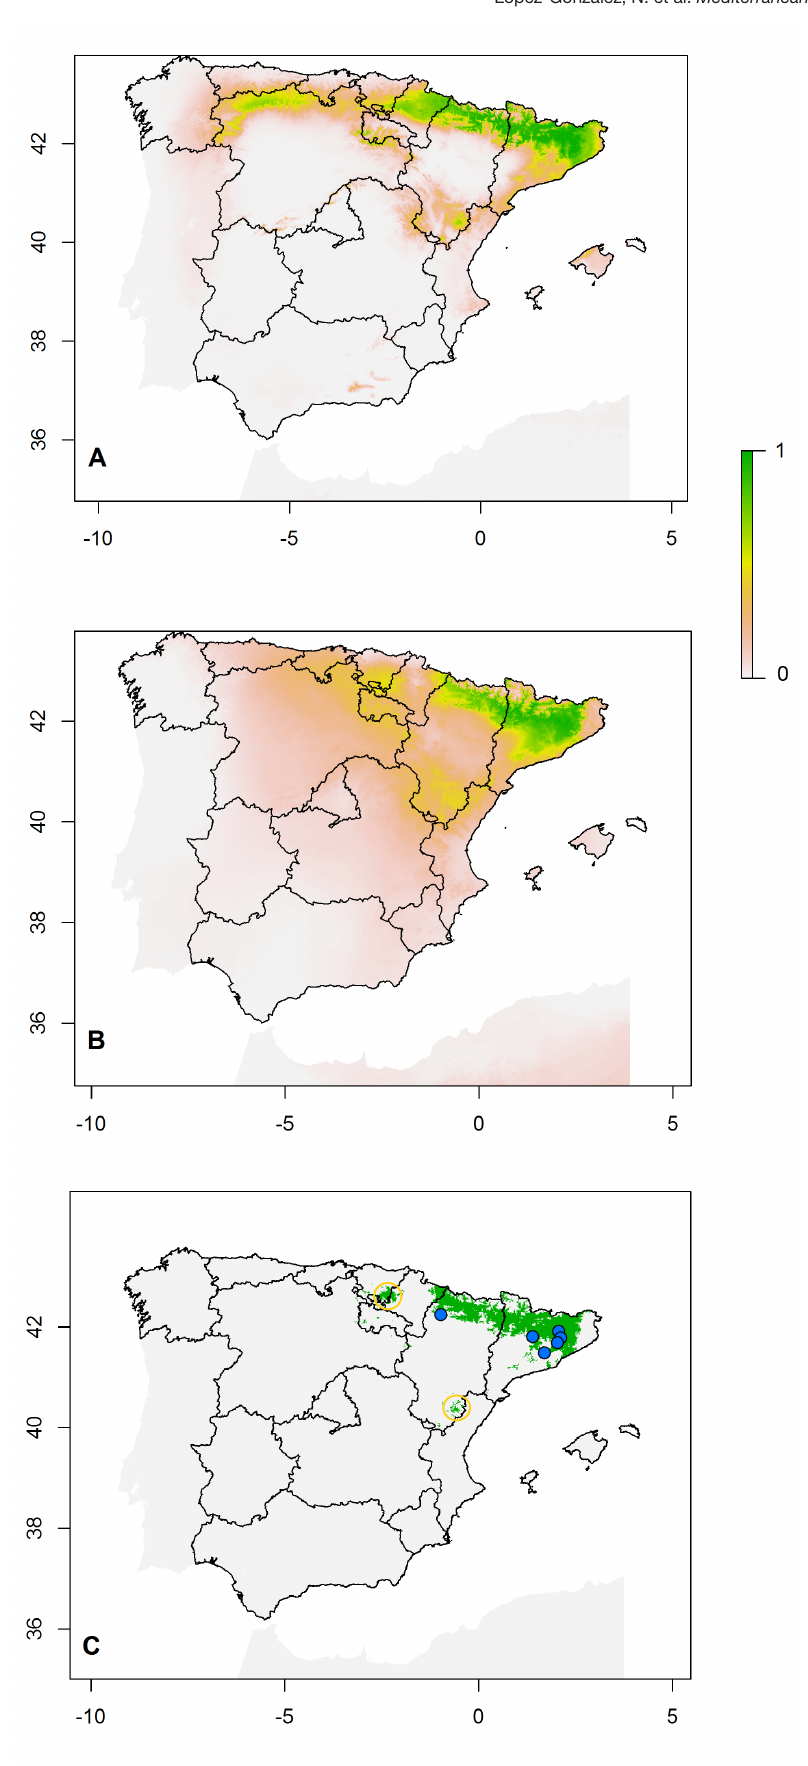
Figure 2. Predicted current environmental suitability for V. orsiniana (A), V. tenuifolia subsp . tenuifolia (B), and possible contact areas between them (C). The colors of the pixels represent their predicted suitability (green: maximum suitability; yellow: medium suitability; white: not suitable areas). Blue points represent known locations of V . × gundisalvi . Orange circles correspond to suggested locations to search for new hybrid